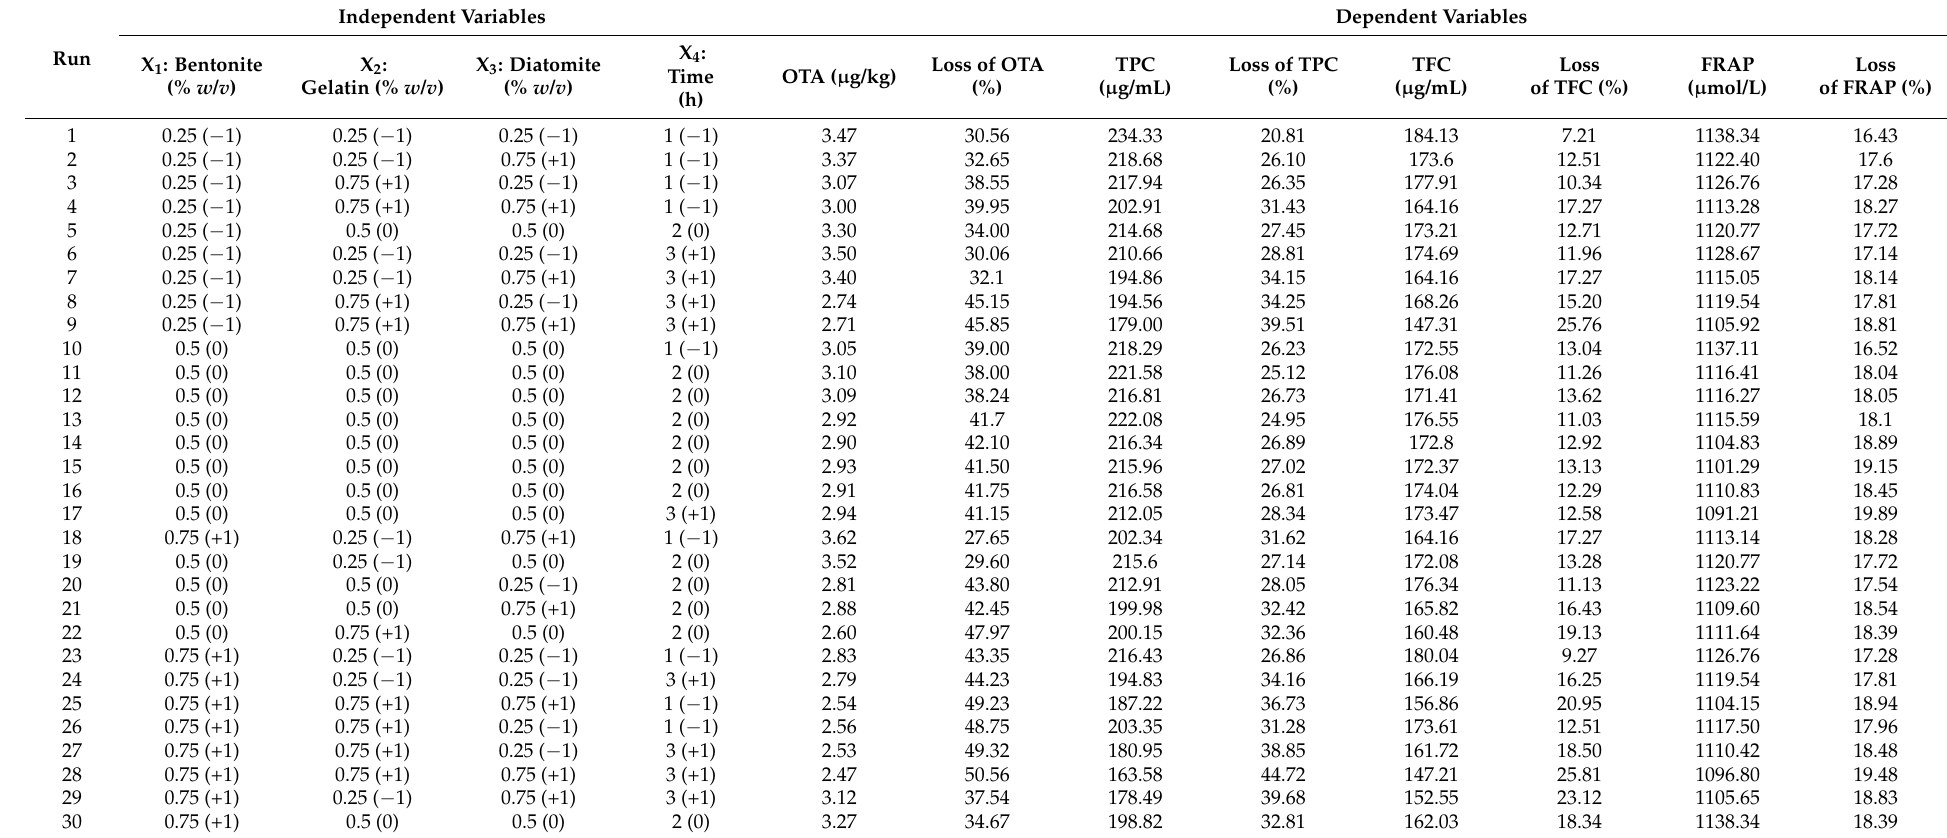
Table 1. Experimental design and results of OTA, phenolic acid, flavonoid, and antioxidant activity reduction percentage during grape juice